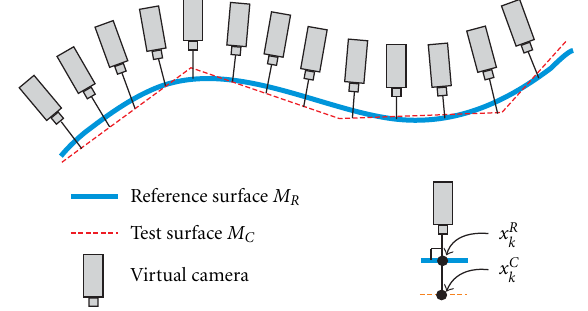
Figure 3: Surface roving method with a virtual